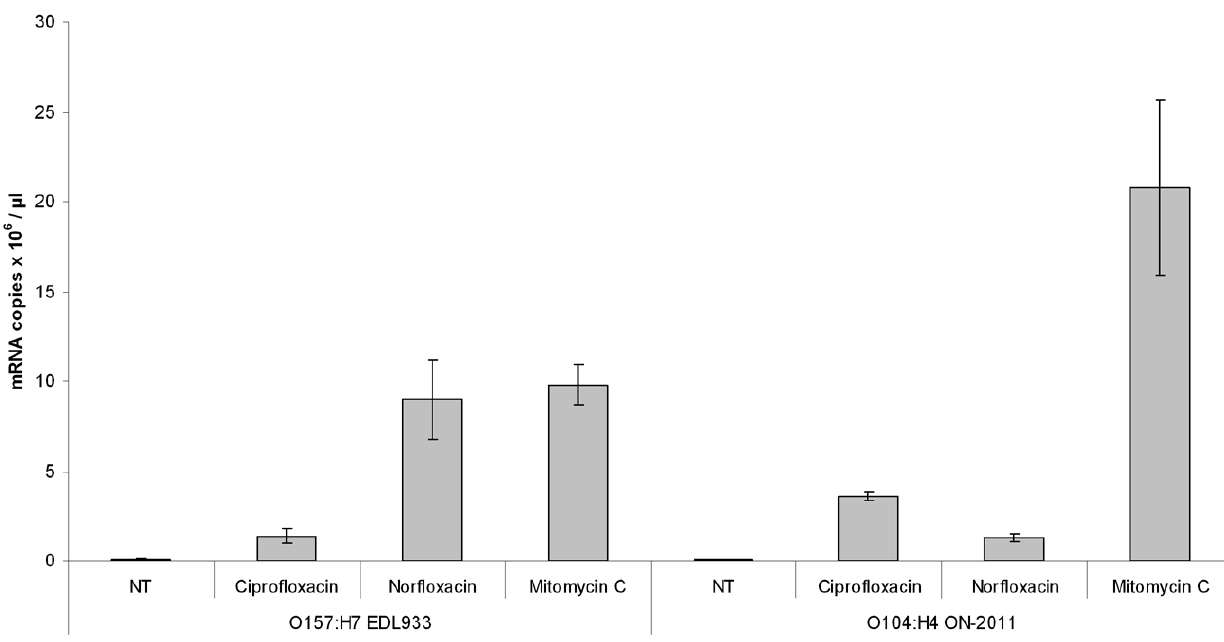
Figure 7. Stx2-mRNA copy number differences between E.coli O104:H4 outbreak-related strain ON-2011 and E.coli O157:H7 strain EDL933 under ciprofloxacin, norfloxacin and mitomycin C treatments. NT= no treatment. Error bars represent standard deviations from three independent replicates.